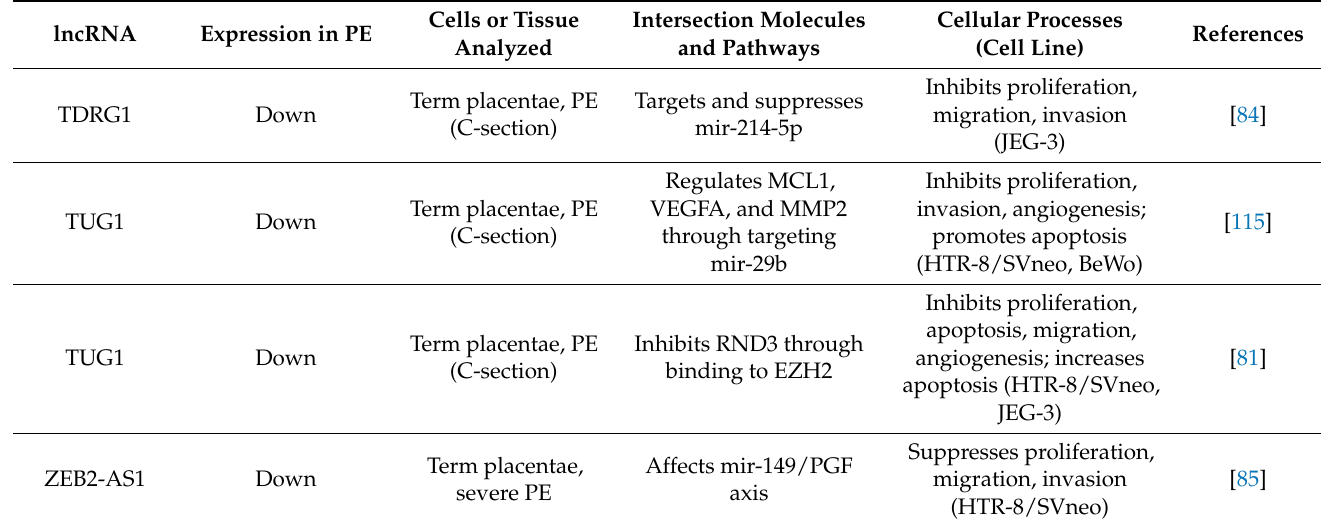
Table Abbreviations: lncRNA, long noncoding RNA; Up, upregulated; Down, downregulated; PE, Preeclampsia; ePE, early-onset Preeclampsia EMT, epithelial-to-mesenchymal transition; MMP, matrix metalloproteinase; C-section, Caesarean